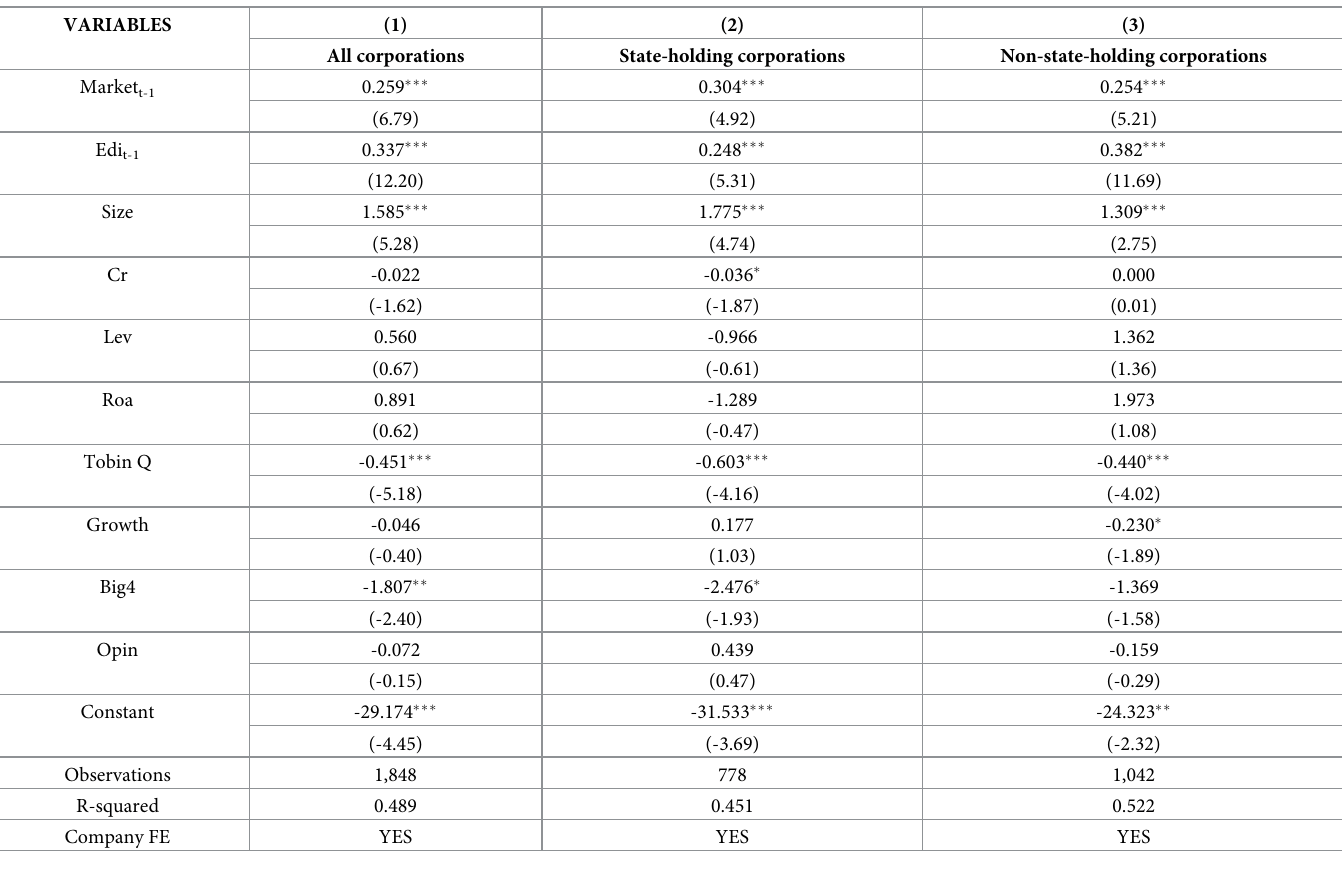
Table 5. Regression test results of intra-industry peer group effect in EID.